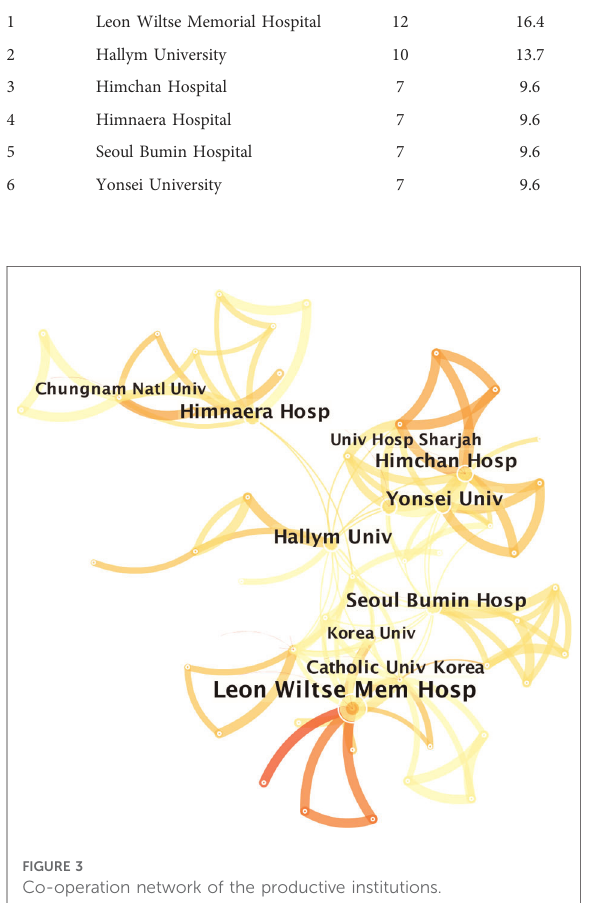
FIGURE 3 Co-operation network of the productive institutions.